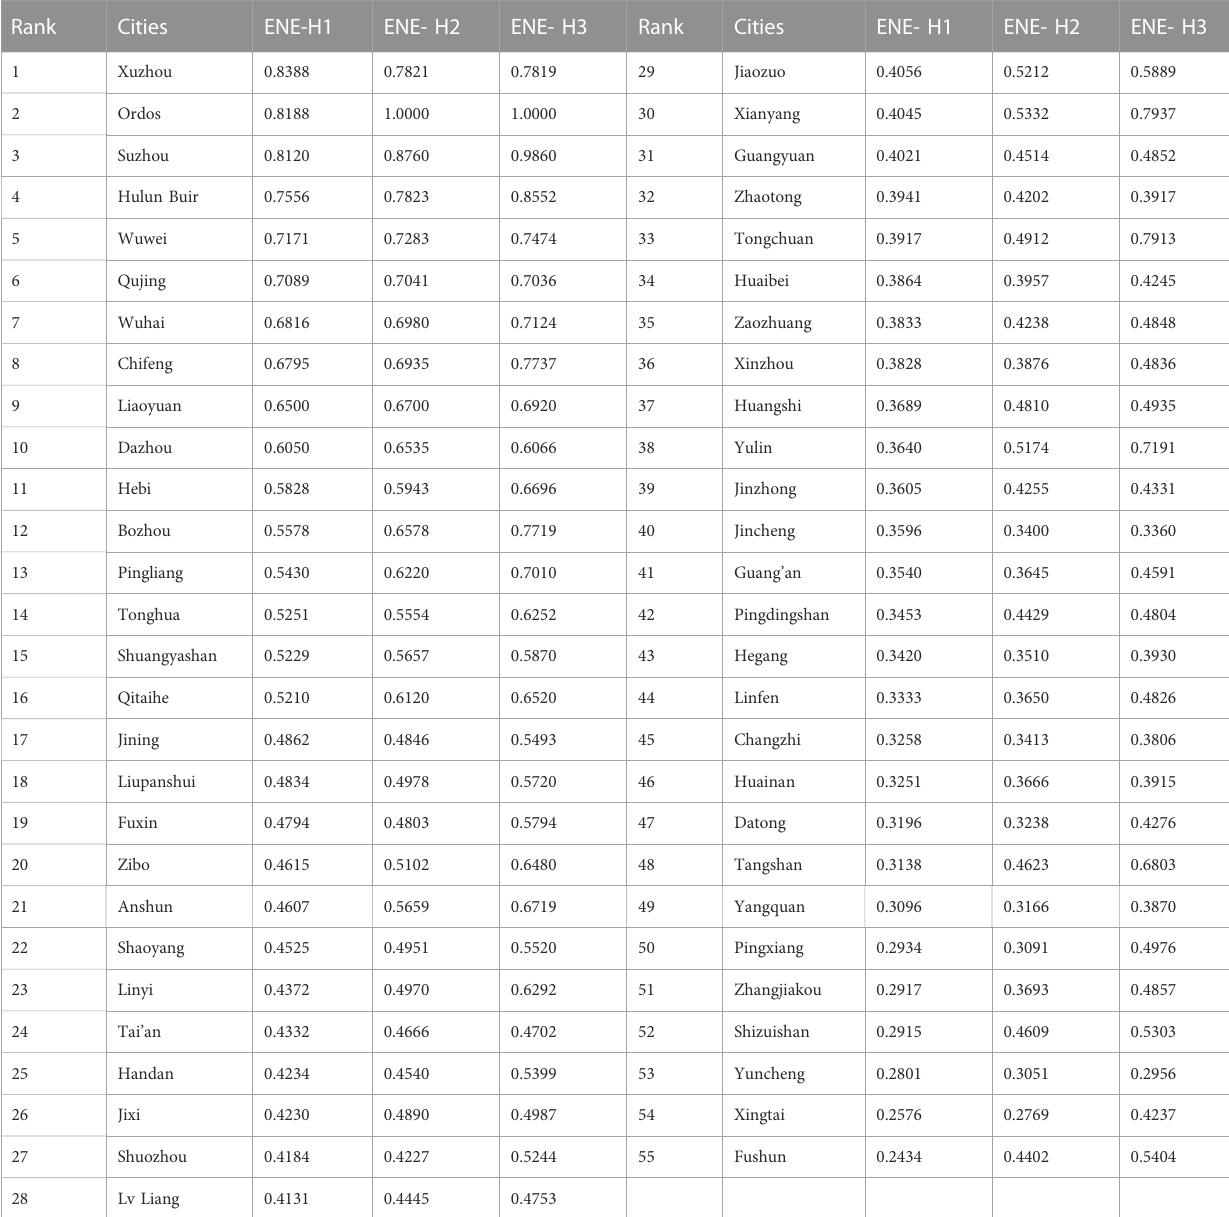
TABLE 3 The ENE of different cities of in the carbon reduce